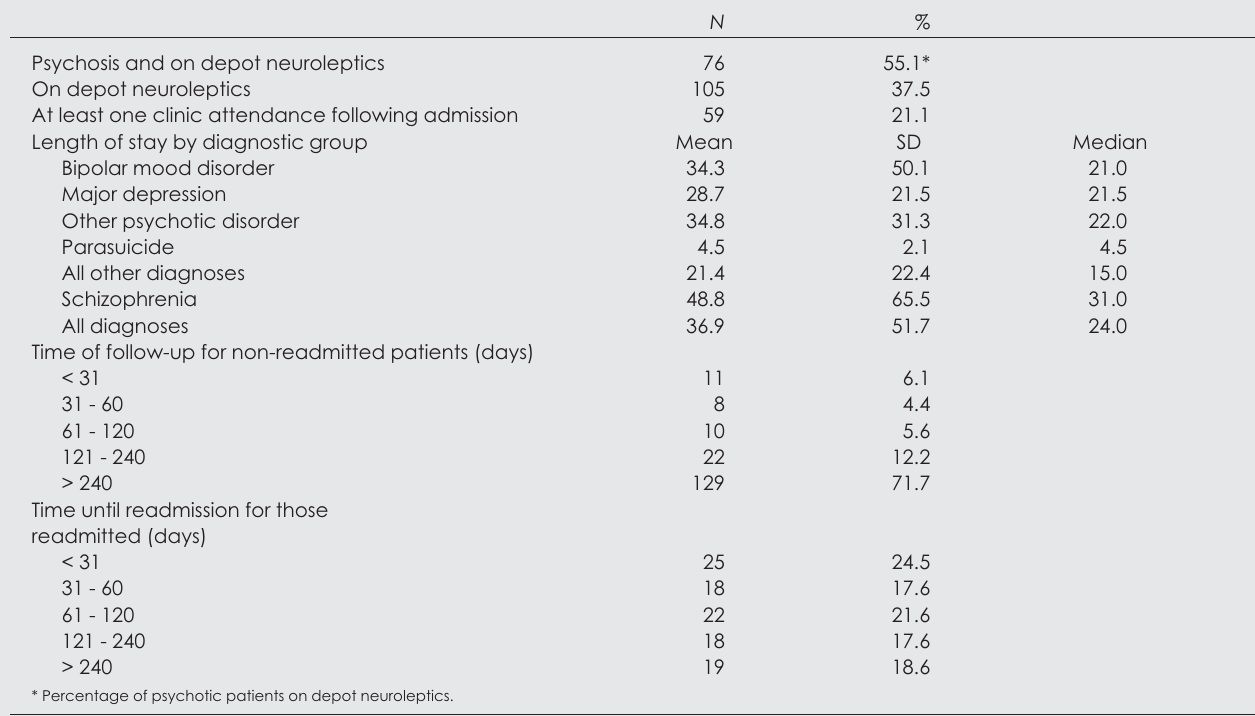
Table II. Descriptive statistics with regard to